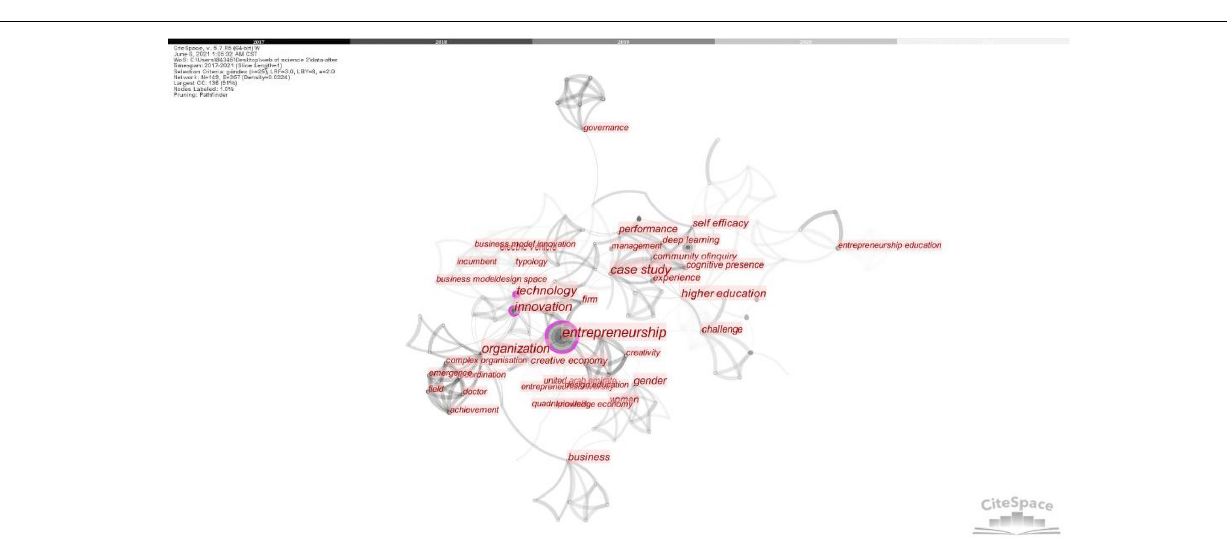
FIGURE 3 | The keyword knowledge map drawn by CiteSpace (Retrieved by our research team and